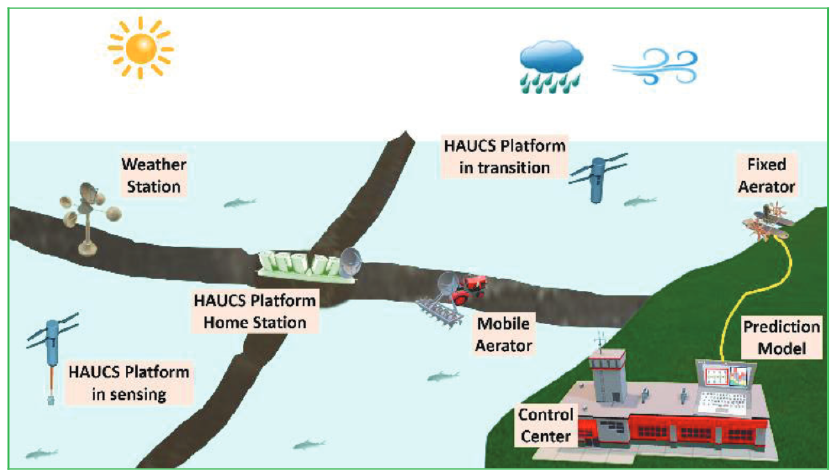
Figure 1. Diagram of the HAUCS concept. Data from the HAUCS platforms and weather stations are integrated in a control center, and conditions can be predicted to enable efficient aeration and pond maintenance. Adapted from